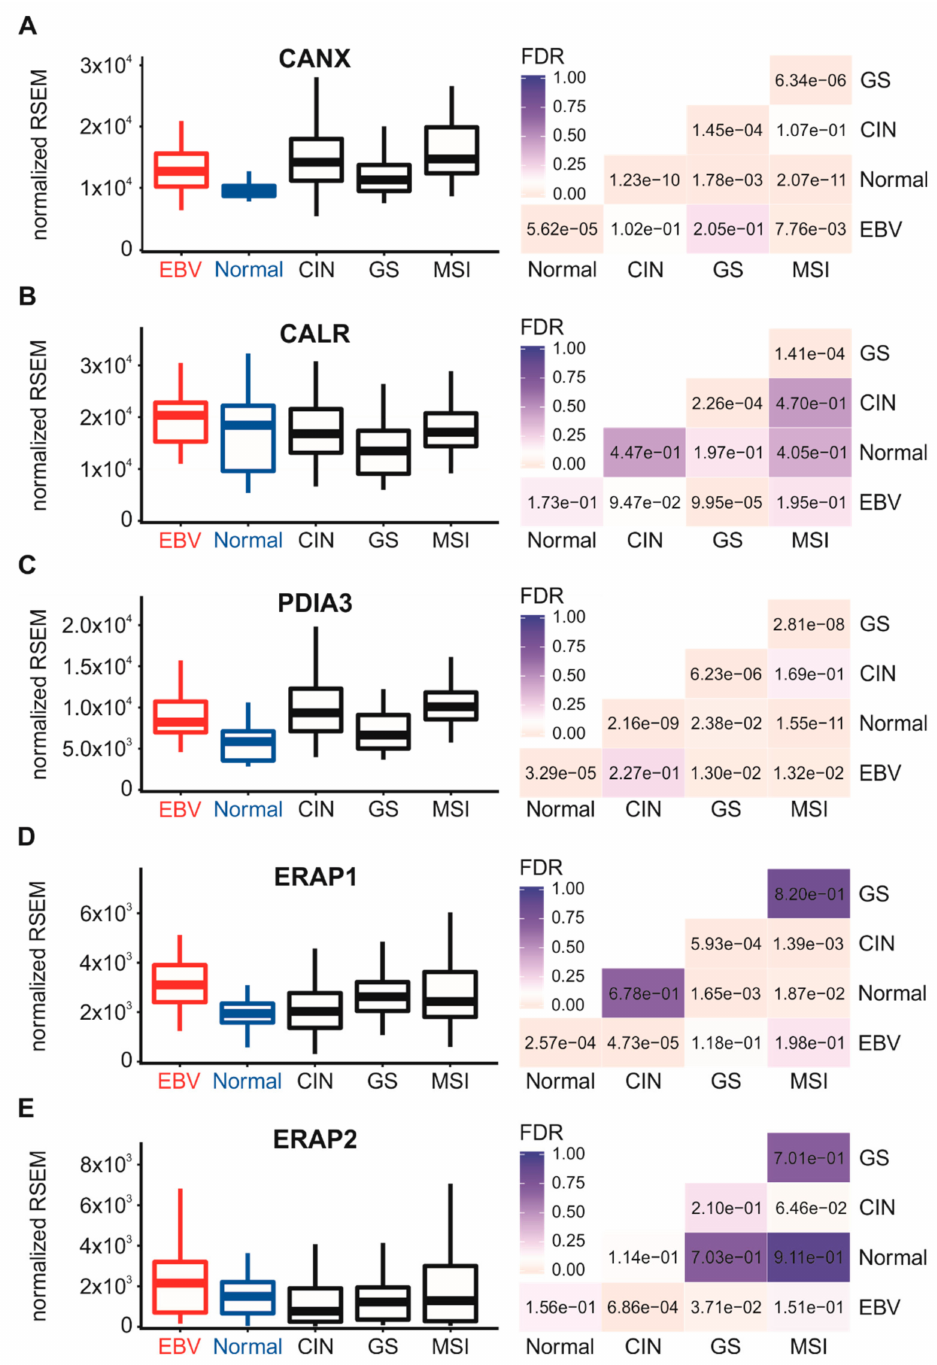
Figure 4. Expression levels of other genes involved in MHC-I-dependent antigen loading in gastric carcinoma subtypes and normal gastric tissue. Normalized RNA-seq data for the CANX ( A ), CALR ( B ), PDIA3 ( C ), ERAP1 ( D ) and ERAP2 ( E ) genes involved in MHC-I-dependent antigen presentation were extracted from the TCGA database for the STAD cohort for EBVaGCs, normal control tissues, and three other GC subtypes. FDR-adjusted p -values for each statistical comparison are shown on the right for each gene